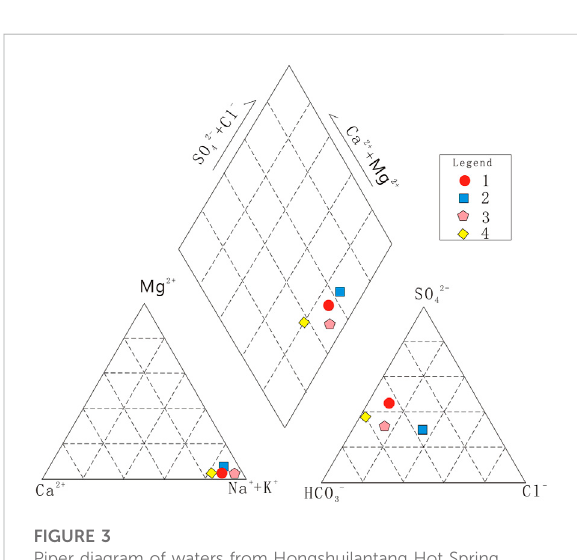
FIGURE 3 Piper diagram of waters from Hongshuilantang Hot Spring. The numbers in the fi gure correspond to those in Table